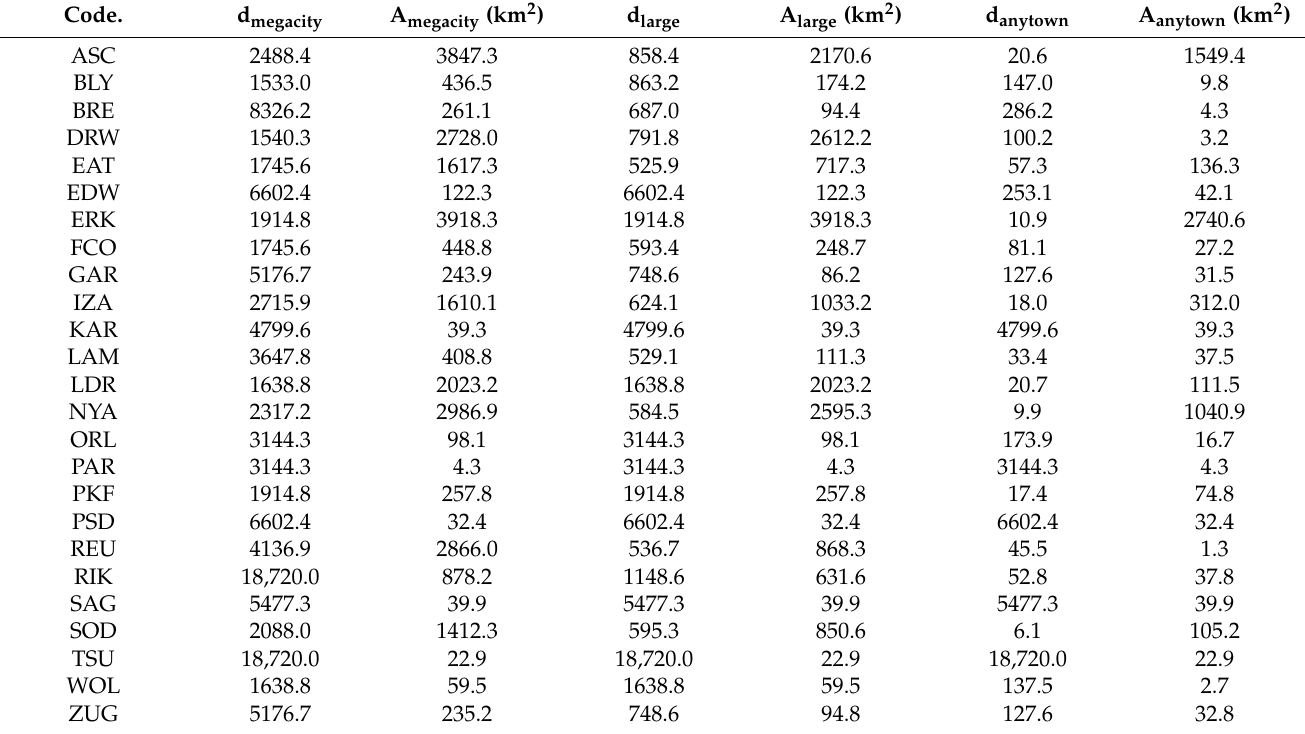
Table 2. Analysis of the role of urban areas in TCCON-to-model disagreement in reproducing MGR. Distance to the closest urban area (d) for any urban area (subscript ‘anytown’), large urban area with >500 km 2 (subscript ‘large’), and for megacity with >1500 km 2 (subscript ‘megacity’). Area estimates, for the same three categories, are given under A-labeled columns.